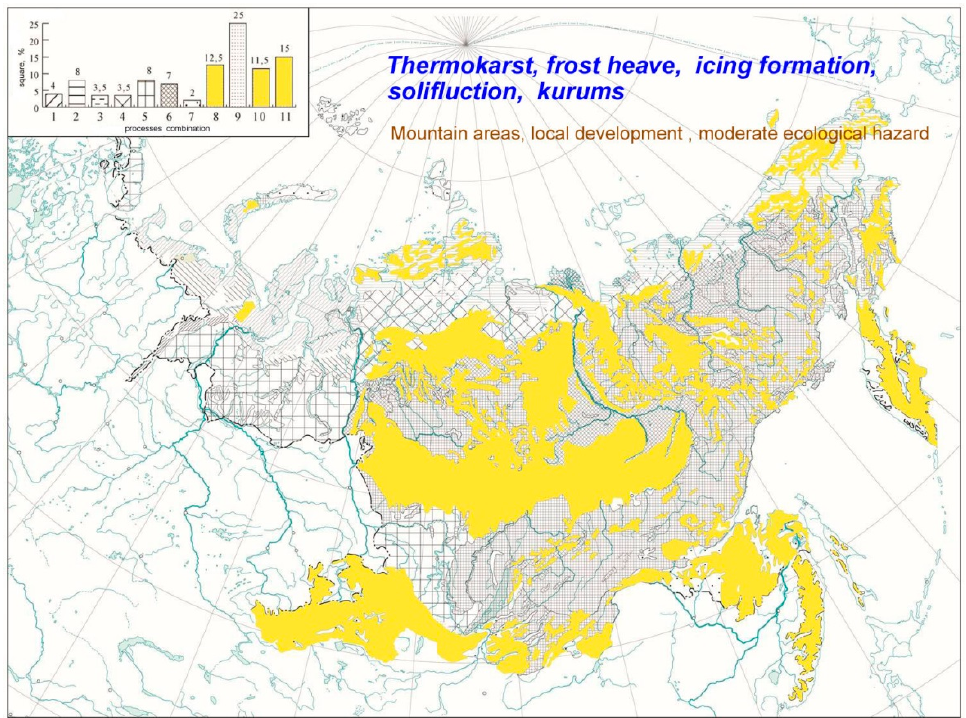
Figure 16. The second group of process combinations (yellow color).